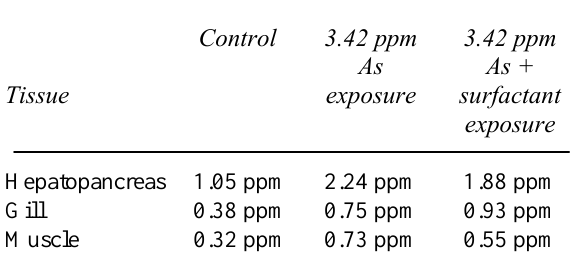
Table 2: Average inorganic arsenic